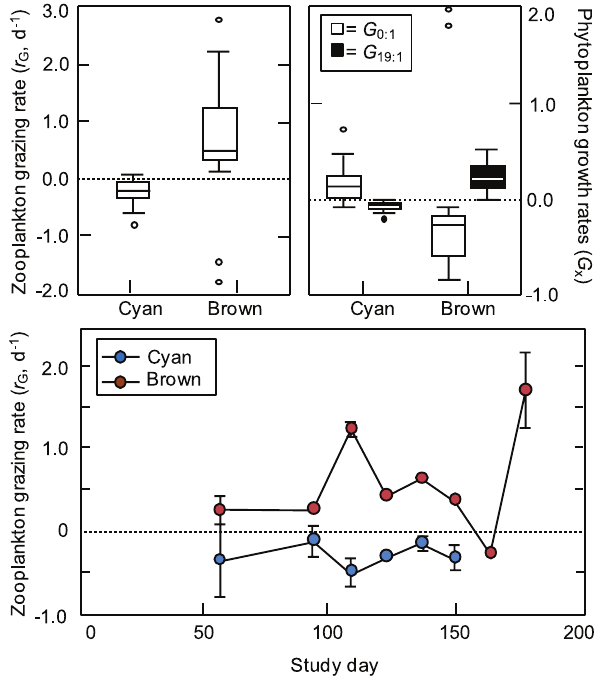
Figure 2. Plankton grazing and growth experiments. Zooplank- ton grazing rates ( r G , day 2 1 ; upper left panel) and phytoplankton specific growth rates under different dilution conditions ( G 0:1 –0:1 [filtered:ambient dilution], G 19:1 –19:1 [filtered:ambient]; upper right panel) calculated from mesocosm experiments with subsurface water from Lake King, Australia. Abscissae of upper plots coded by fluorescence color channels: cyan (cyanobacteria), brown (diatoms/ dinoflagellates). Box plot components: measure of central tendency=- median, outer edges of box=25 th and 75 th interquartile range, whiskers=quartiles –(1.5 6 interquartile range), circles=outliers. Time- series of average r G (error bars show 6 1 SD) for the cyan and brown fluorescence channels (lower panel). The x-axis shows the number of days elapsed since 1 September 2011 (study day=1).